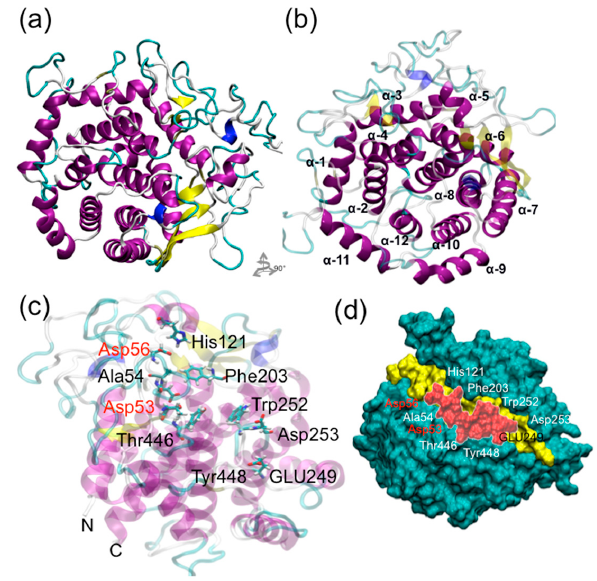
Figure 4. FaEG1 protein model. ( a ) Frontal view of the FaEG1 3D-structure that was built using the 1KS8 protein as a template (40.5% identity). ( b ) Top view of the FaEG1 structural model. ( c ) Important residues involved in the protein-ligand interaction, the oriented in the open groove is showed, in red the two catalytic residues. ( d ) Surface of the FaEG1 protein model shown in green, while the open groove is shown in yellow